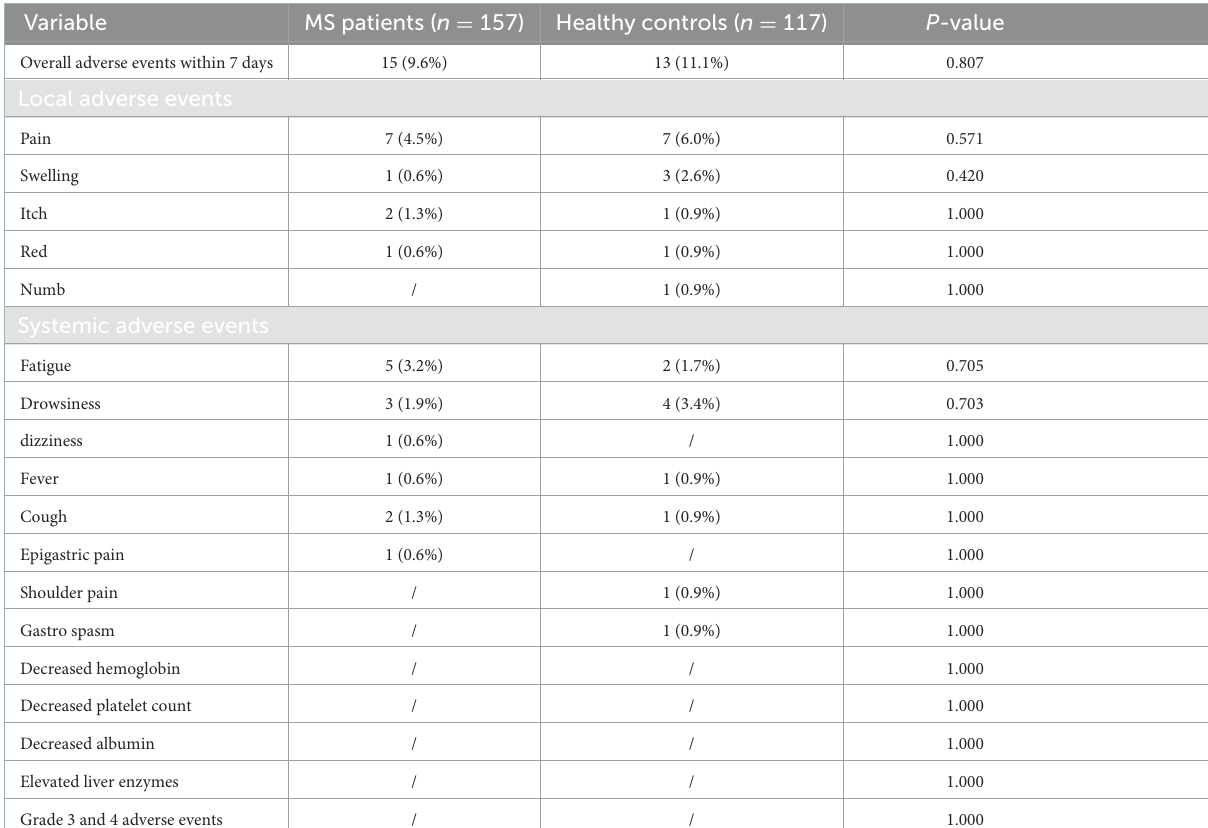
TABLE 2 Adverse events of inactived COVID-19 vaccination in MS patients and health controls.